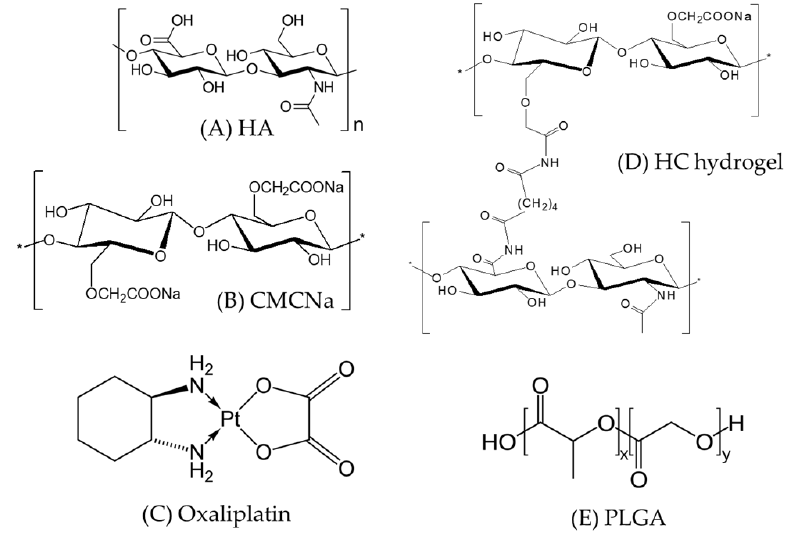
Figure 1. Chemical structures of Poly-( D , L -lactide- co -glycolide) (PLGA) microparticles and hyaluronic acid (HA) and carboxymethyl cellulose sodium (CMCNa)-based cross-linked (HC) hydrogel components ( A ) HA; ( B ) CMCNa; ( C ) HC hydrogel; ( D ) Oxaliplatin; and ( E ) PLGA.